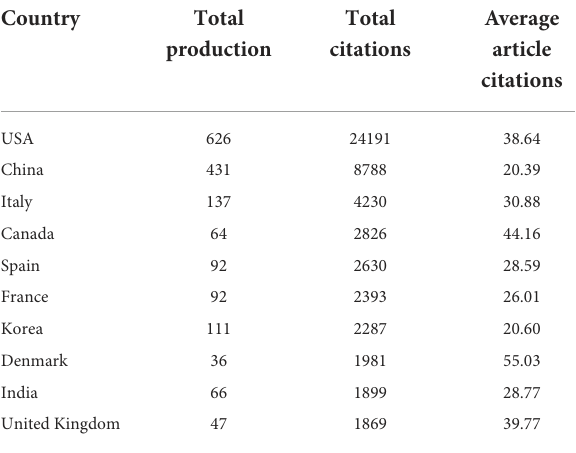
TABLE 1 Top 10 cited countries contributing to this research area.